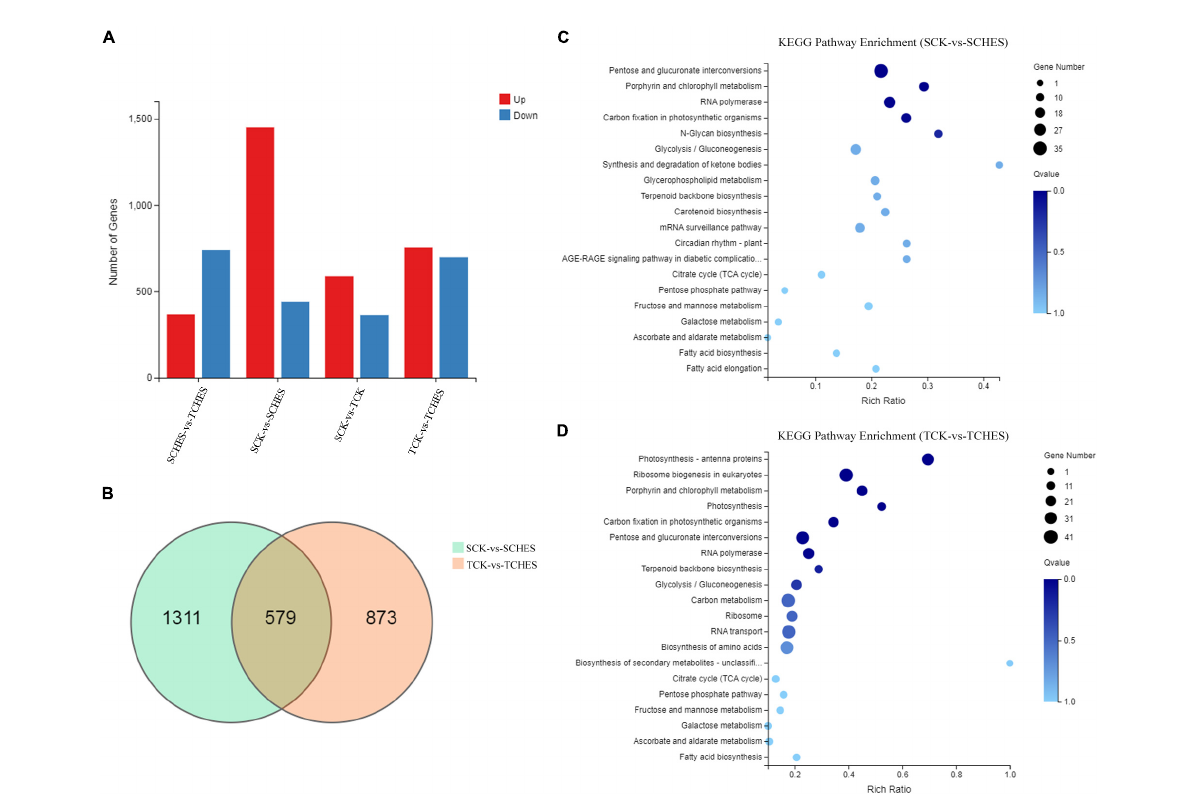
FIGURE4 Overview of DEGs under CHES treatment in P. tricornutum . (A) An overview of up and down-regulated genes in four comparisons. (B) Venn diagram illustrating the DEGs in two comparisons (SCK-vs-SCHES; TCK-vs-TCHES). (C,D) KEGG pathway enrichment analysis of DEGs in the response to CHES treatment after 2 or 3 days culture. SCK and TCK means P. tricornutum cultured in control treatment for 2 and 3 days, respectively; SCHES and TCHES means P. tricornutum cultured in CHES treatment for 2 and 3 days,